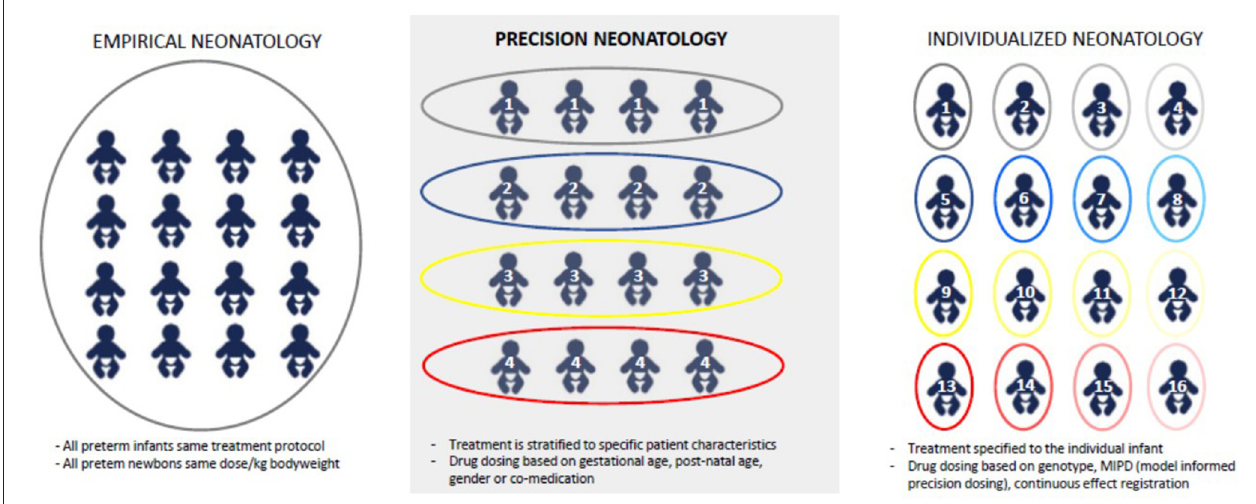
FIGURE 1 | Different concepts related to empirical medicine, precision medicine, or individualized